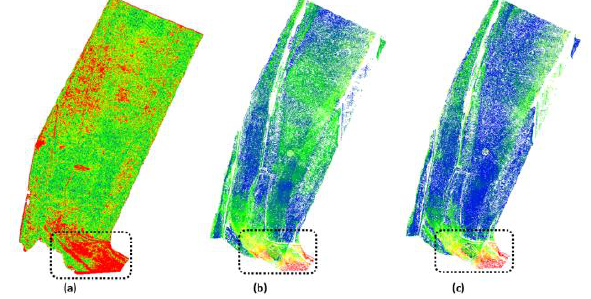
Figure 30. The comparison analysis between the outputs of cloud to cloud distance computations – (a) C2C results from UAV-Photogrammetric data, (b) C2C result from mobile laser scanning data for match bounding-box centres method and (c) C2C result from mobile laser scanning data for ICP method